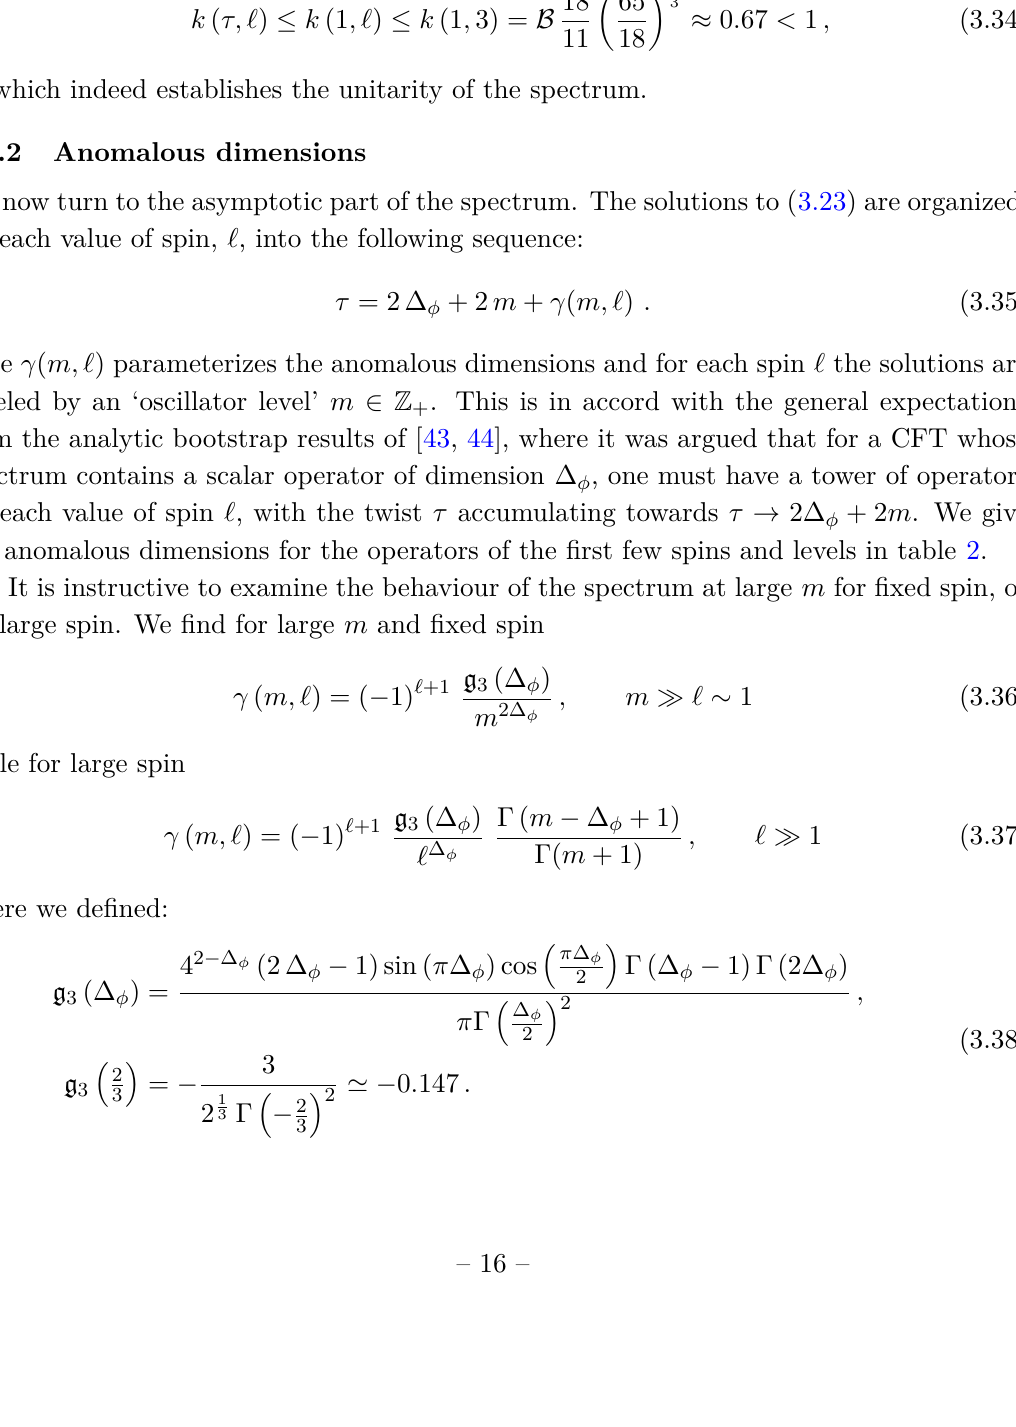
For each ‘ the r.h.s. is a monotonically increasing function for τ < 1 , and hence obtains its maximum at τ = 1 . The resulting function of ‘ is monotone decreasing and is bounded in turn by the value at ‘ = 3 .